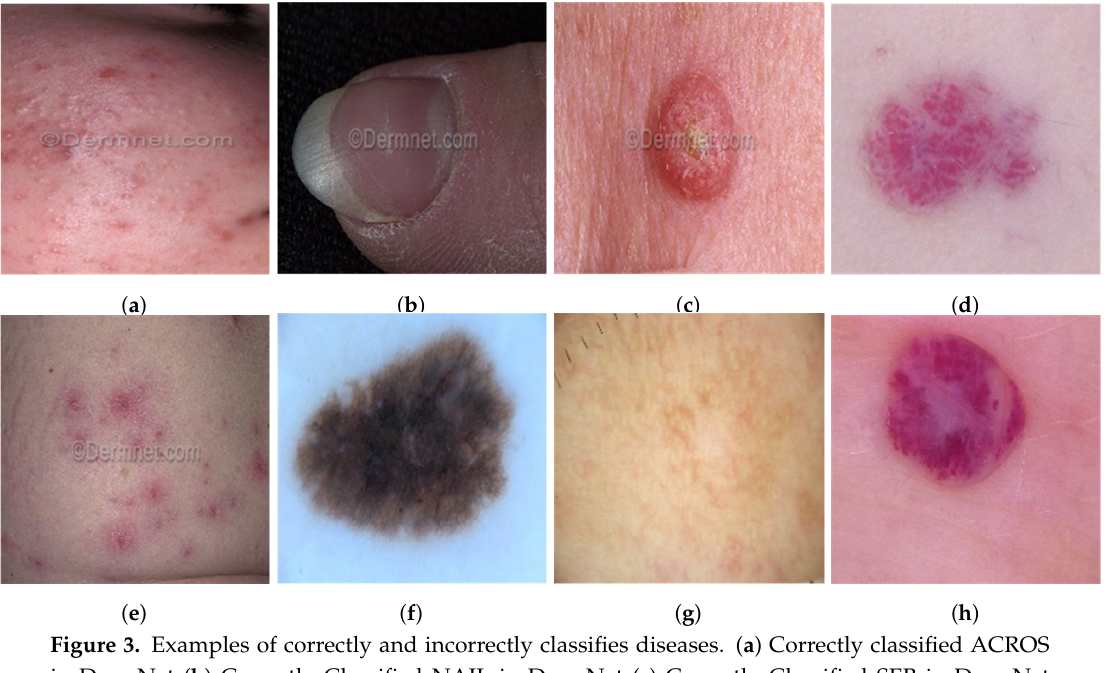
Figure 3. Examples of correctly and incorrectly classifies diseases. ( a ) Correctly classified ACROS in DermNet ( b ) Correctly Classified NAIL in DermNet ( c ) Correctly Classified SEB in DermNet ( d ) Correctly Classified VASC in ISIC ( e ) CEL Misclassified as ACROS in DermNet ( f ) Correctly Classified AKIEC in ISIC ( g ) BKL Miscalssified as MEL in ISIC ( h ) NV Misclassified as VASC in ISIC. All Images are resized to fit in square